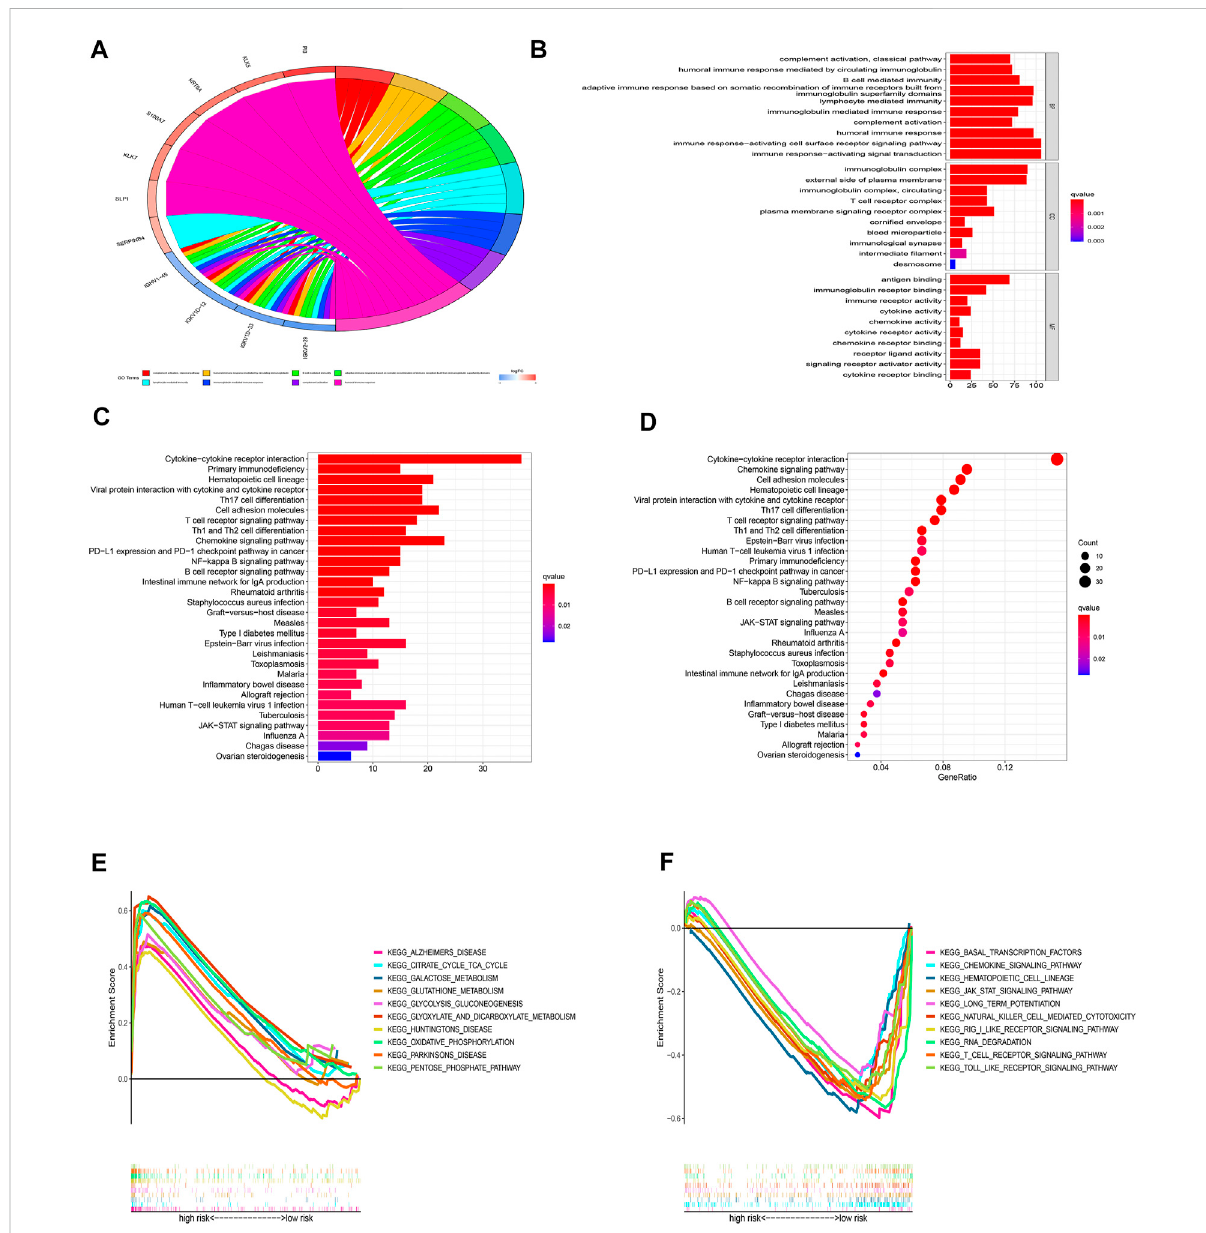
FIGURE 10 Functional enrichment analyses. (A-B) GO analysis based on DEGs between high- and low-risk groups. (C-D) KEGG analysis based on DEGs between high- and low-risk groups. (E-F) GSEA enrichment